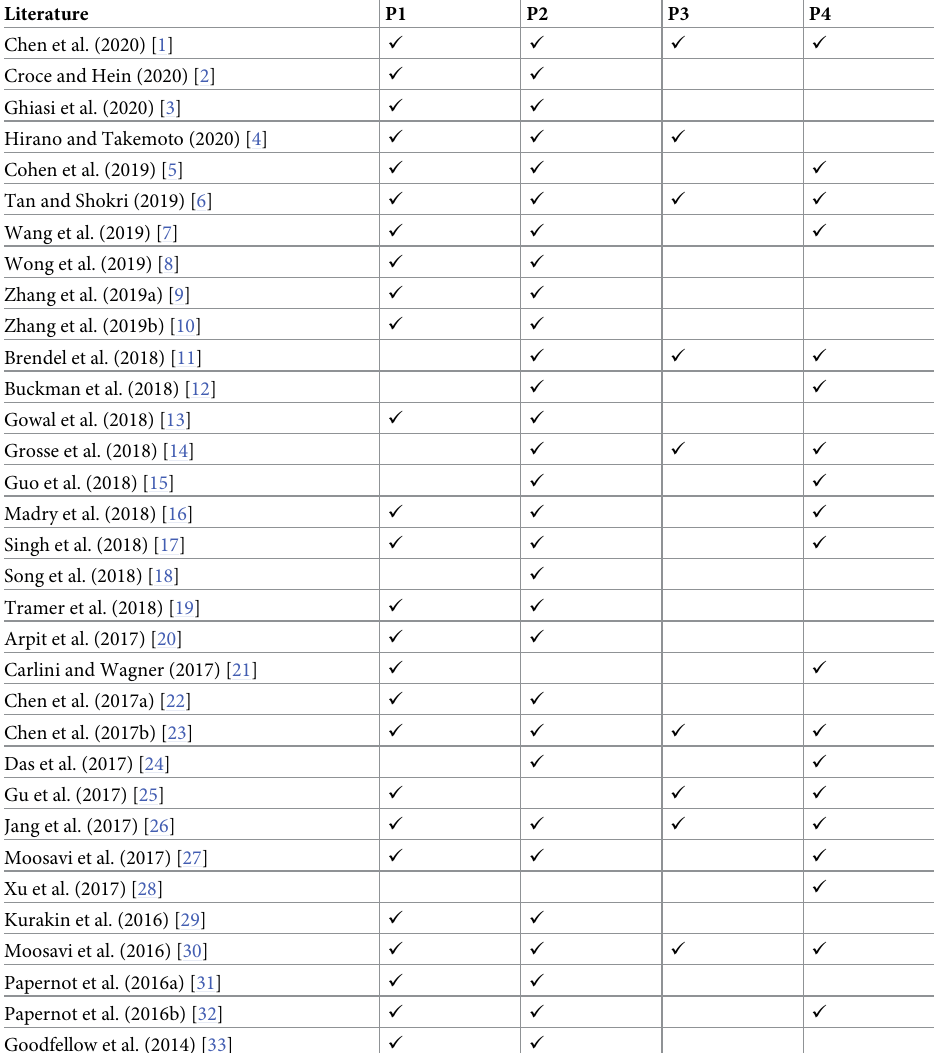
Table 1. Problems in robustness assessment of other